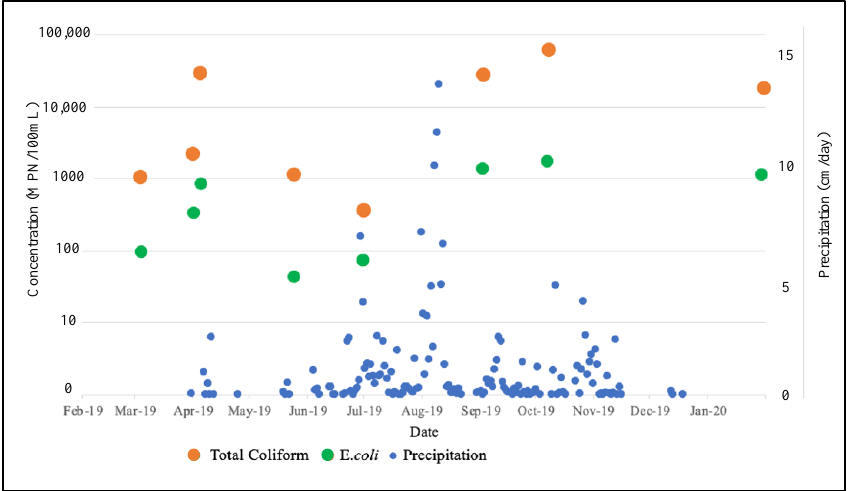
Figure 4. Time series of E. coli and total coliform in untreated water collected at the village’s main water source (Pharth). Precipitation data from rain gauges at Belgaum Sambra field station [26]. Full-Scale IBF System